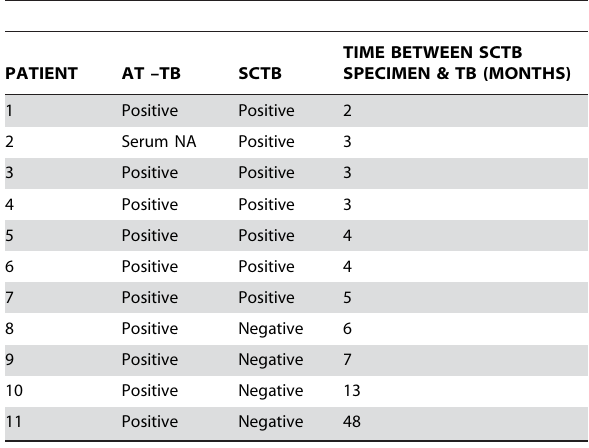
Table 1. Presence of anti-MS &/or –MPT51 antibodies during SCTB in HIV + TB +